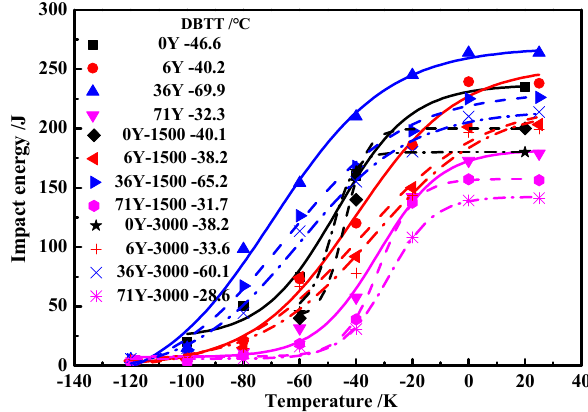
Figure 7. Impact absorbed energy of the aged alloys.